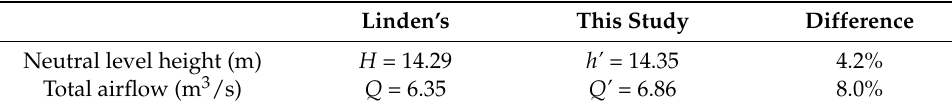
Table 5. Airflow rate on each floor.